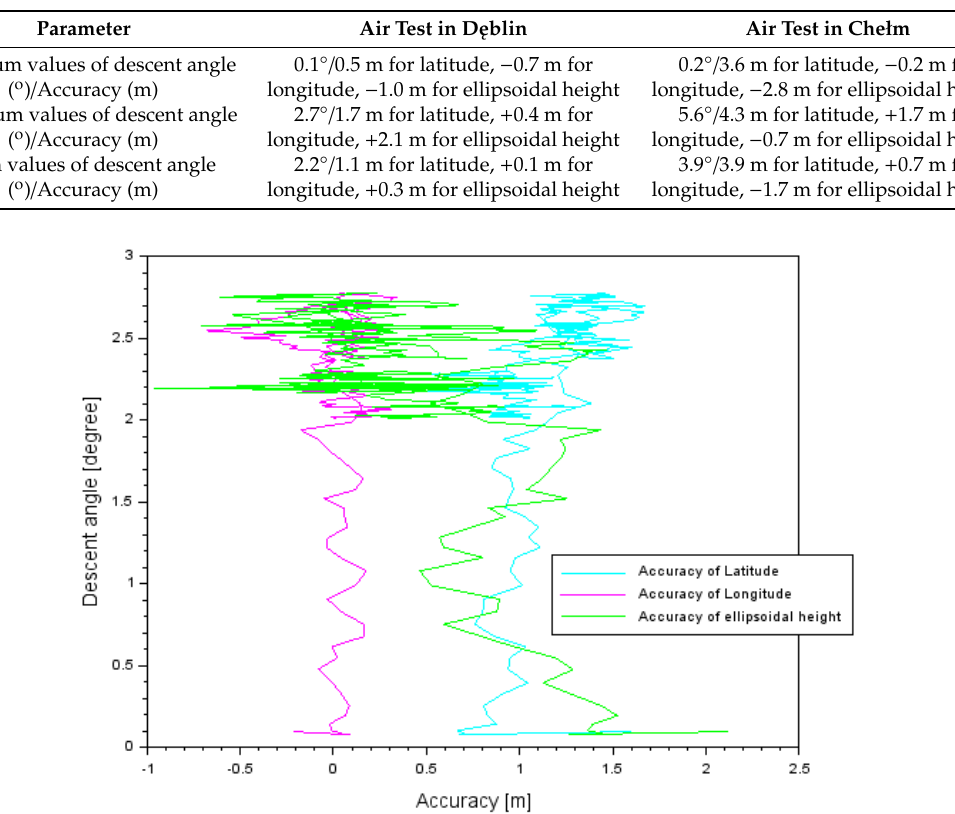
Figure 9. The descent angle in relation to accuracy results in the air test in D ę blin.